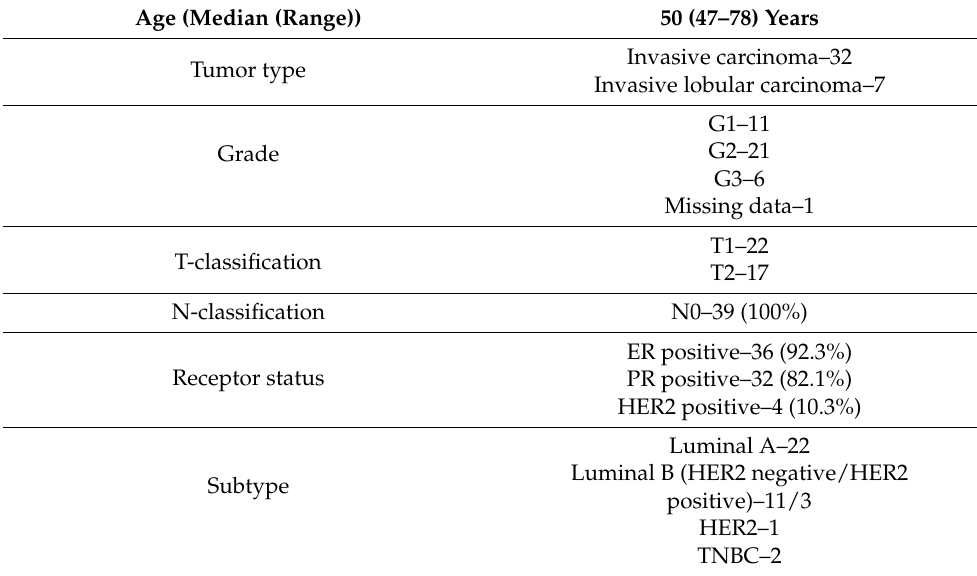
Table 1. The patients’ clinico-pathological